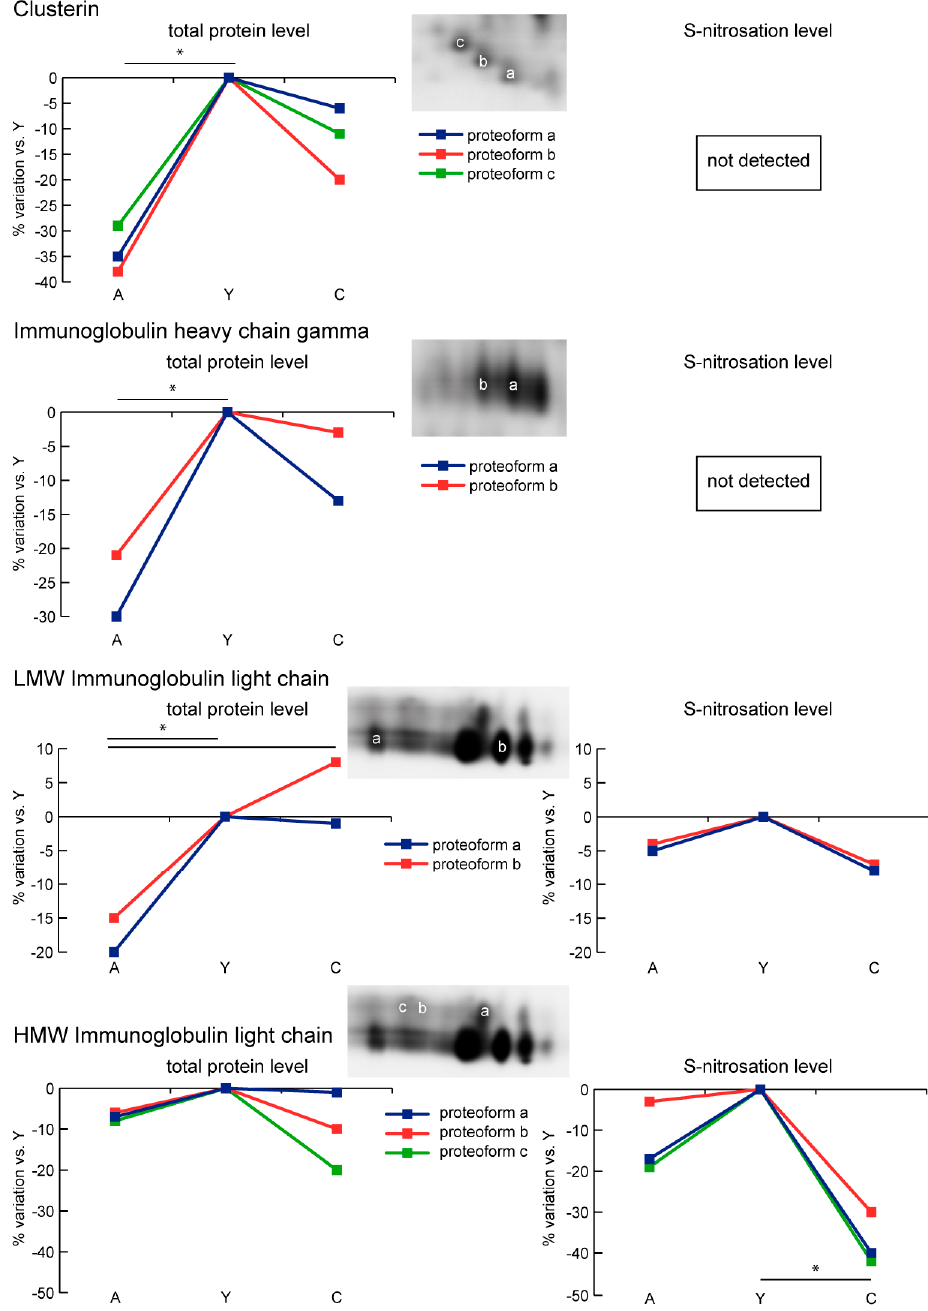
Figure 5. Line charts illustrating clusterin (CLU), immunoglobulin heavy chain gamma (IGHG3), and immunoglobulin light chain (IGLC1) proteoform abundance and S-nitrosation level variations (%) in sera of aged (A) and centenarian (C) compared to young (Y) women. Proteins were divided according to the statistical significance of the test (* = significant difference, ANOVA and Tukey, n = 6 (2-D DIGE) or n = 9 (Nitro-DIGE), p -value < 0.01).